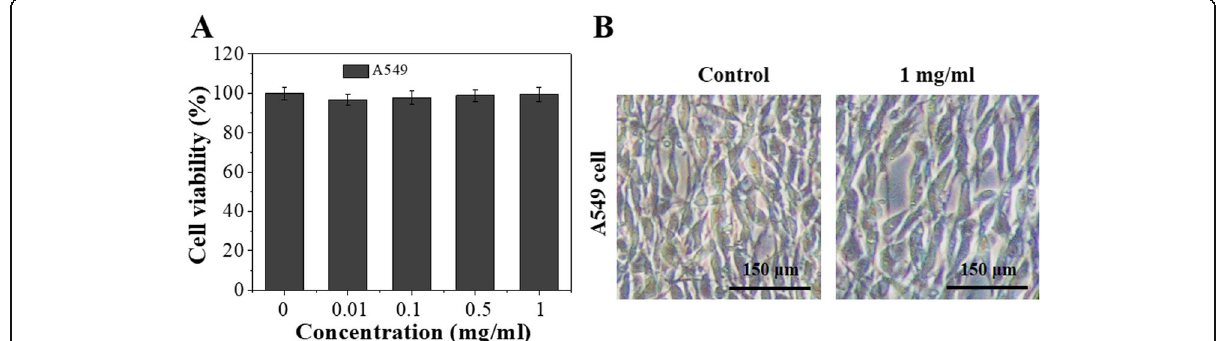
Fig. 5 a In vitro cytotoxicity against A549 cells treated with different concentration of Ft-RGD for 24 h. b The microscope image of A549 cells after 24 h treatment with 1 mg/mL of Ft-RGD